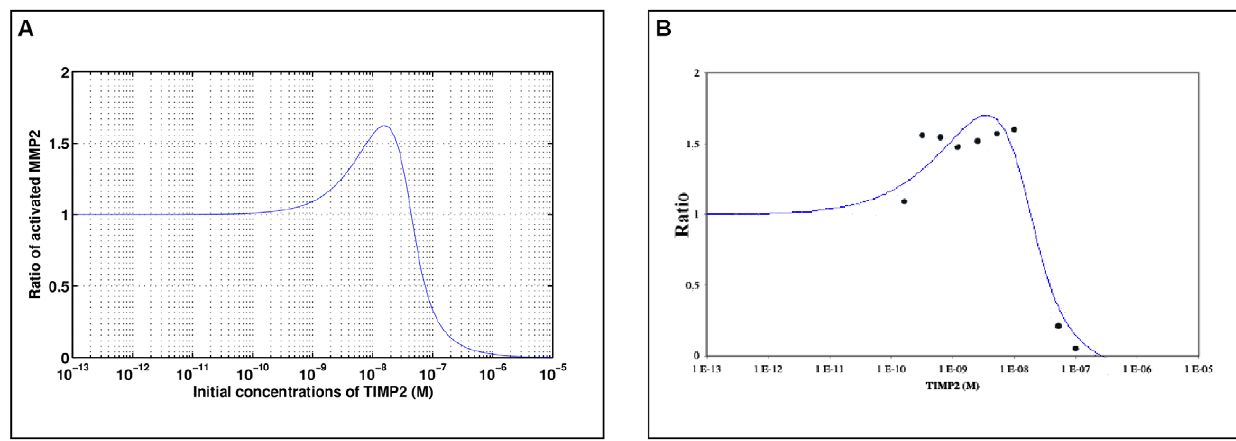
Figure 5. Asserting the predictive power of the model. A : ratio of the concentration of activated MMP2 after 1 hour over the concentration obtained when TIMP2 is absent as simulated by our model. Initial concentration of MT1-MMP proMMP2 was 41.7 nM and 1.39 nM respectively , these values corresponding to the 20 ng of MT1-MMP and 1 ng of proMMP2 used in Kinoshita et al experiments [39]. The initial quantity of the complex MT1-MMP/TIMP2 was set to 7 nM to ensure that the reference activation of proMMP2 in the absence of TIMP2 is non null. B : experimental measurements of the activation replotted from [39].